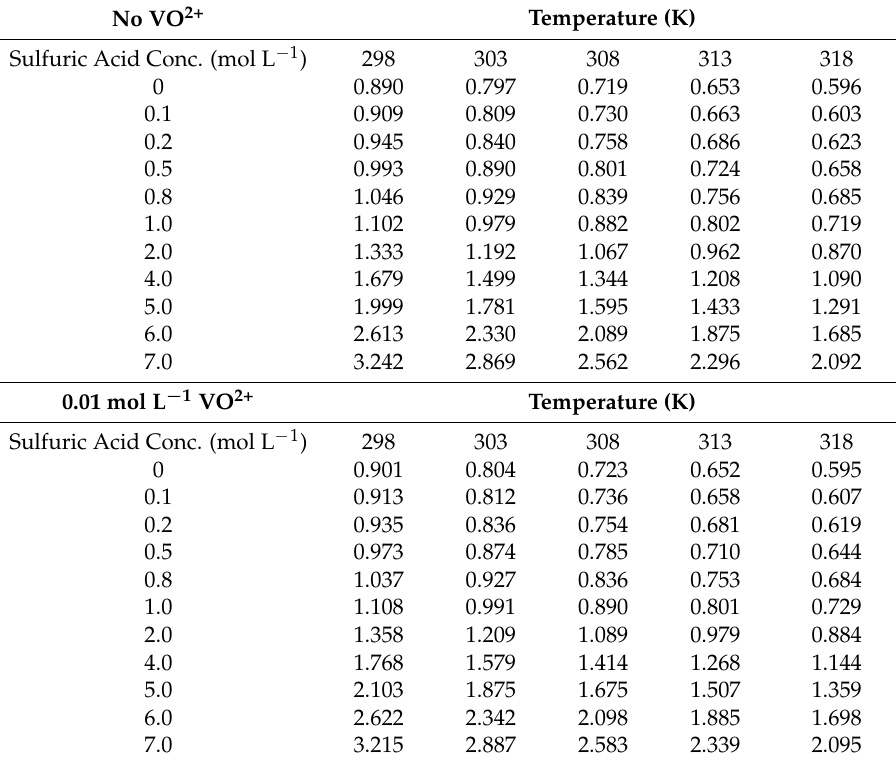
Table A2. Dynamic viscosity of sulfuric acid/sulfuric acid VO 2+ electrolytes at the indicated temperatures, in units of centipoise (cP).